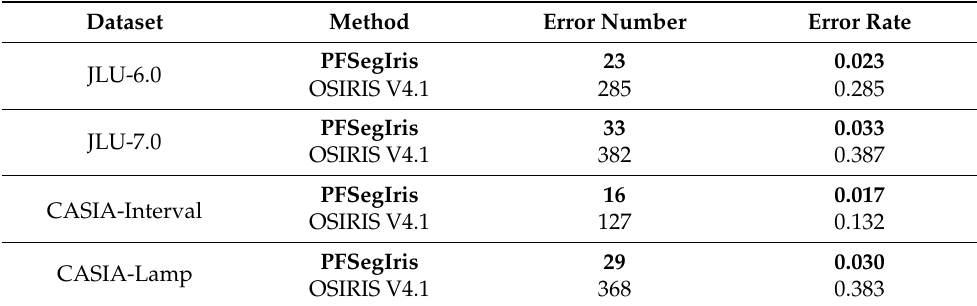
Table 8. Comparison of experimental